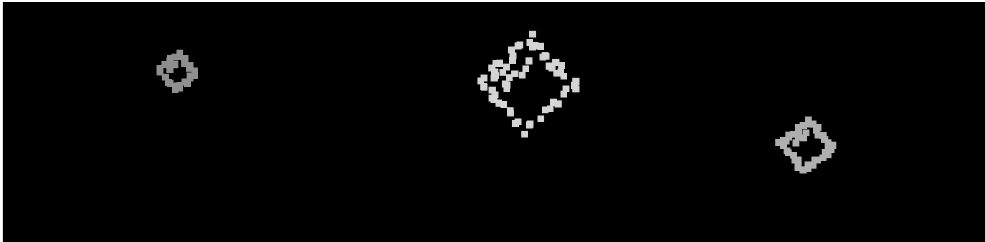
Figure 9. Samples from the LiDAR